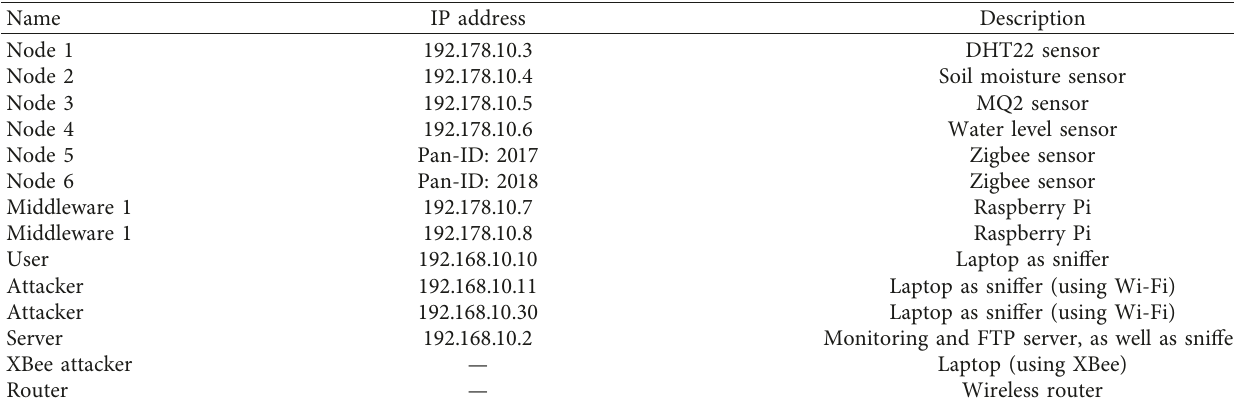
Figure 4: Testbed topology. Table 1: List of equipment for the